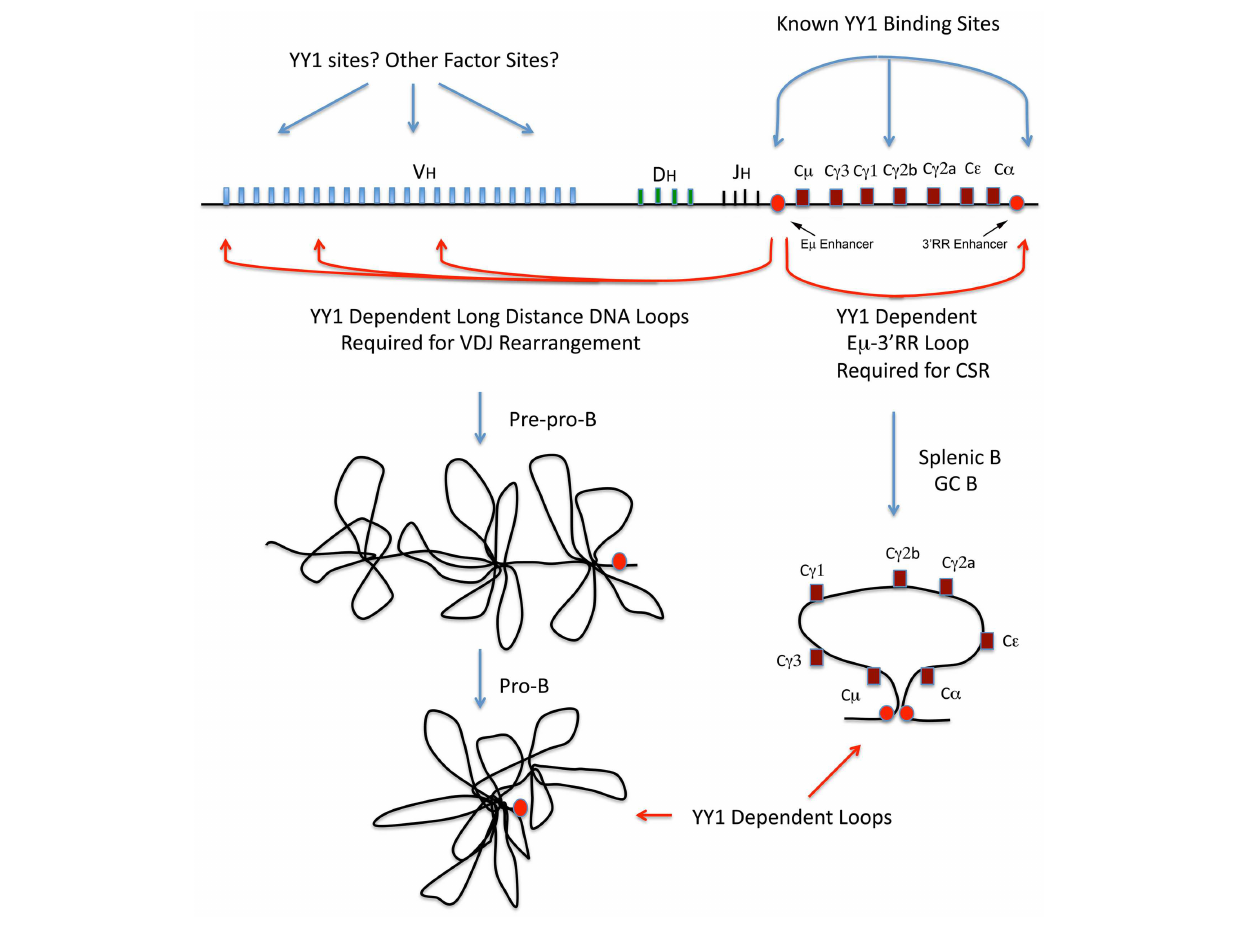
3 (cid:48) RR enhancers.The left panel models rosette-like loops encompassing theV H regions at the pre–pro-B and pro-B cell stages. The right panel diagrams the E µ -3 (cid:48) RR long-distance DNA loop required for